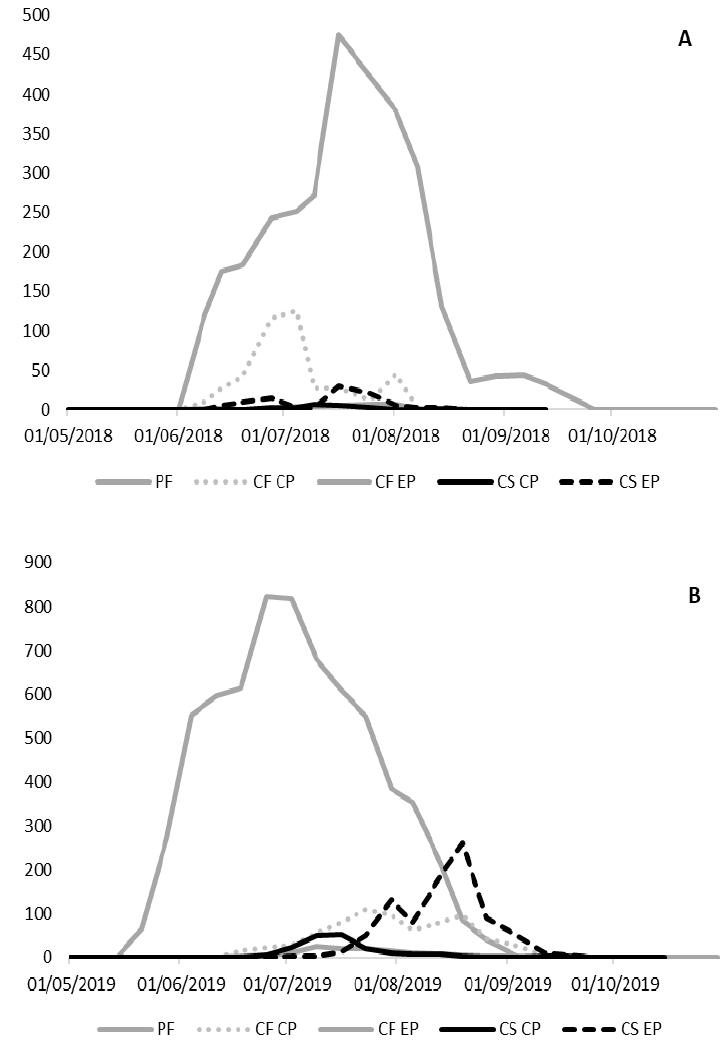
Figure 6. Seasonal flight activity of Cydia splendana (Hübner) recorded in the surveyed sites using the experimental available pheromone (grey bars refer to 2018, black bars to 2019. For each bar, the triangle corresponds to the population peak).